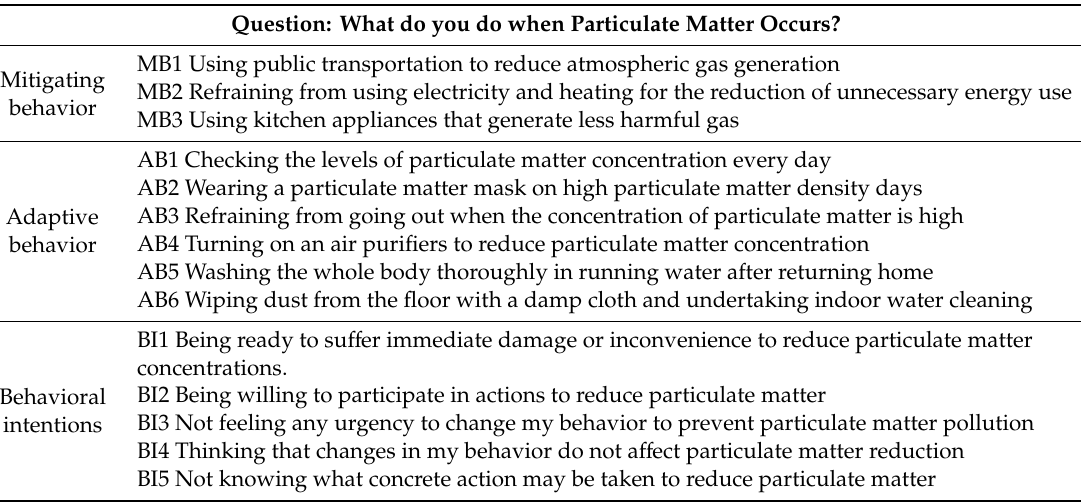
Table 4. Responsive behaviors to particulate matter.